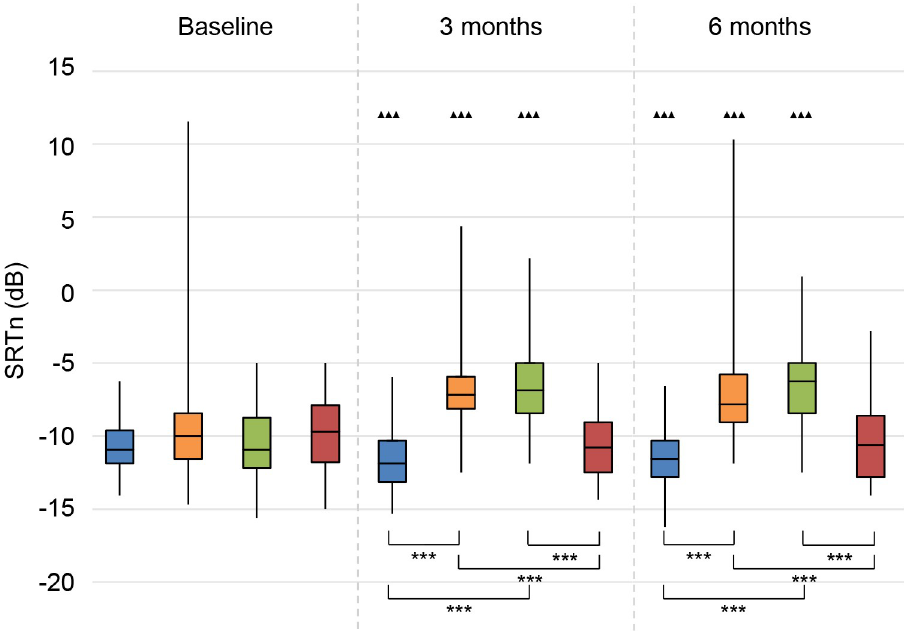
Fig 4. Speech perception in noise. Speech reception threshold in noise (SRTn) in decibels (dB), configuration S be N pe . Statistical difference compared to baseline. ▲▲▲ = p < 0.001; ▲▲ = p < 0.01; ▲ = p < 0.05. Statistical difference compared to 3 months follow-up. ■■■ = p < 0.001; ■■ = p < 0.01; ■ = p < 0.05. Statistical difference between groups at same follow-up moment. ��� = p < 0.001; �� = p < 0.01; � = p <